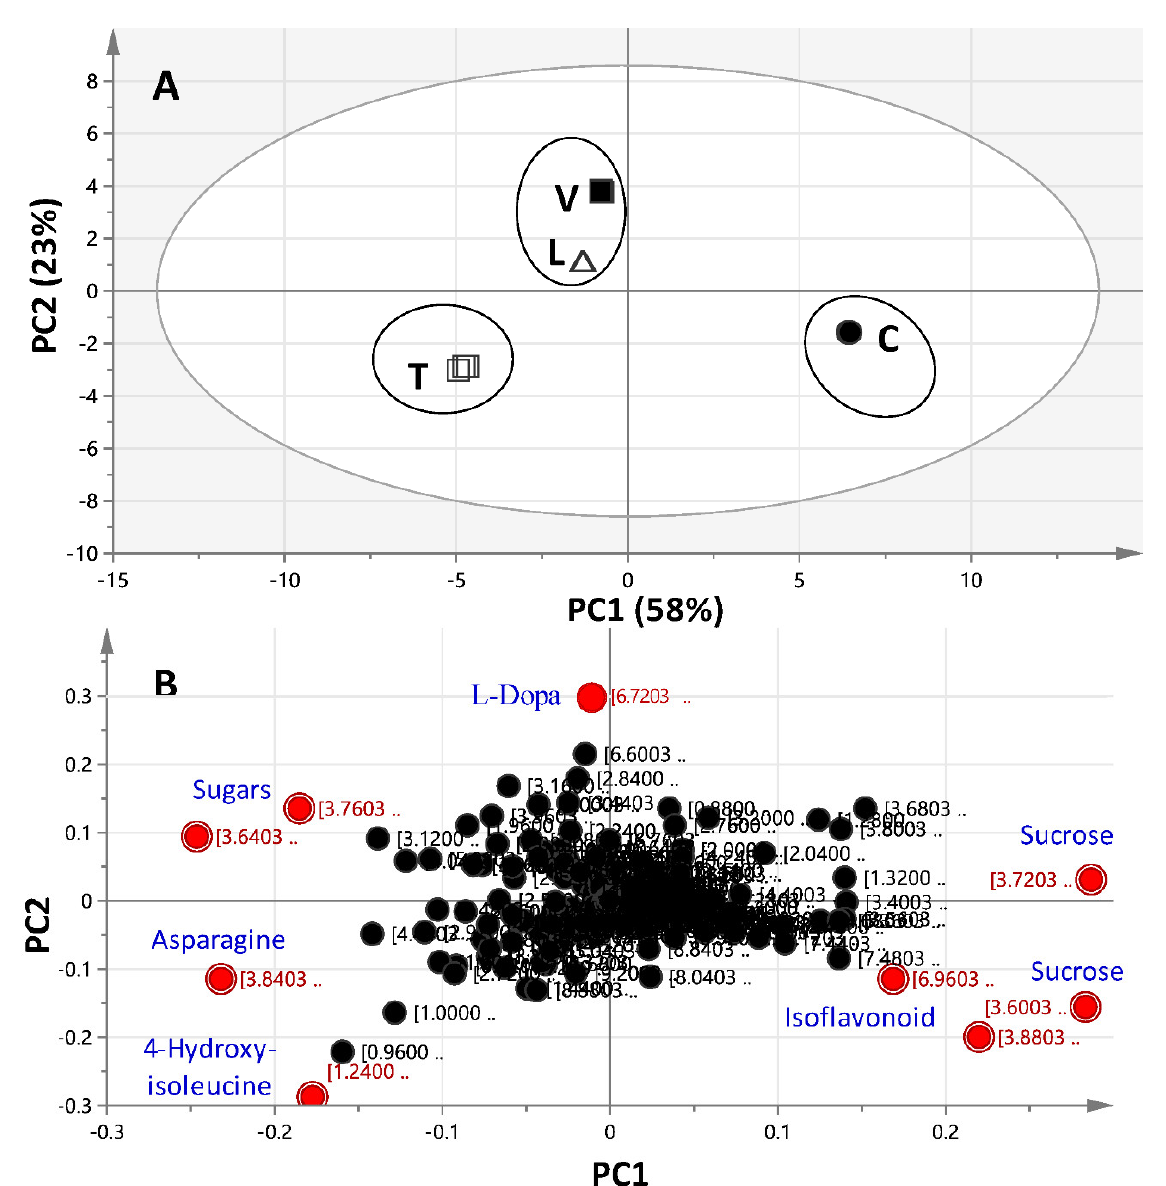
Figure 3. 1 H-NMR ( δ 11.0–0.0 ppm)-based principal component analysis (PCA) of the four studied legume sprouts: Cicer (C), Lens (L), Trigonella (T), and Vicia (V) ( n = 3). The clusters are located at distinct positions in two-dimensional space described by two vectors of principal components PC1 (0.58) and PC2 (0.23). ( A ) Score plot of PC1 vs. PC2 scores. ( B ) Loading plot for PC1 and PC2 contributing 1 H-NMR signals and their assignments, with each metabolite denoted by its chemical shift (ppm). It should be noted that ellipses do not denote statistical significance but are rather added for better visibility of clusters discussed. For sample codes, refer to Table 1.